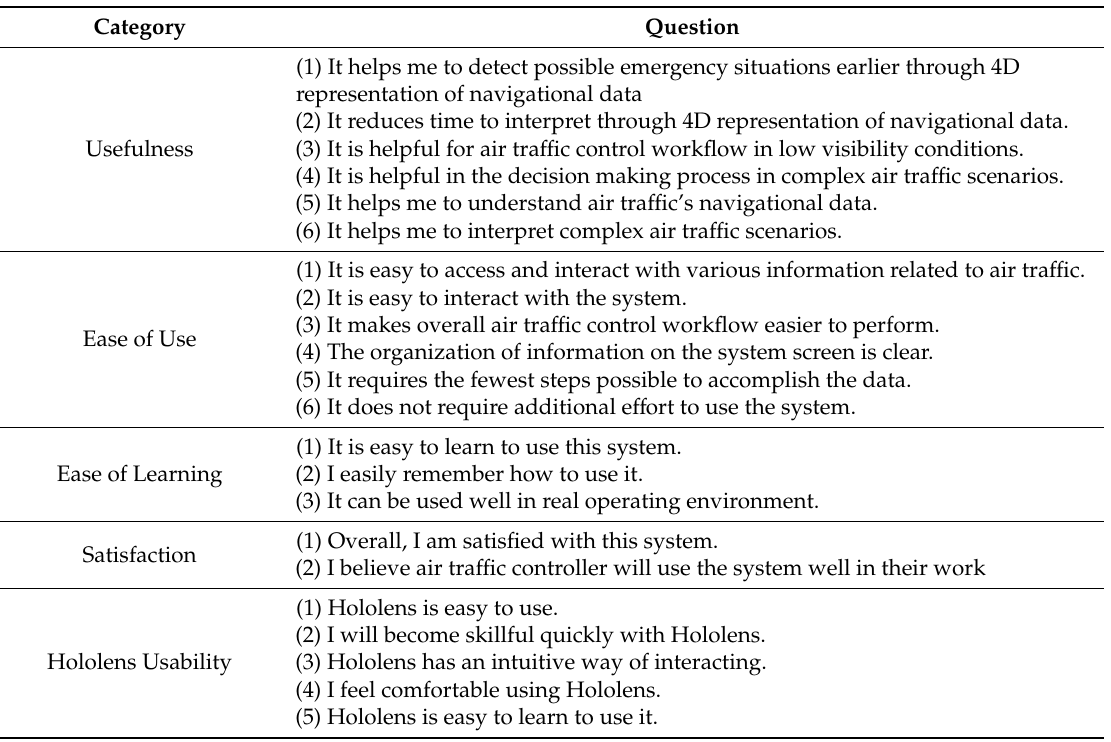
Table 2. Holographic mixed reality system